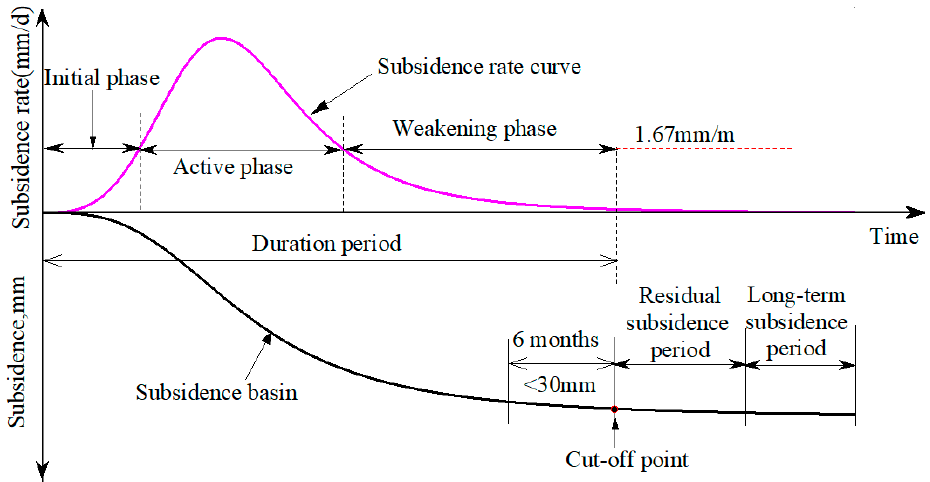
Figure 2. Surface movement process for MSP during longwall coal mining.